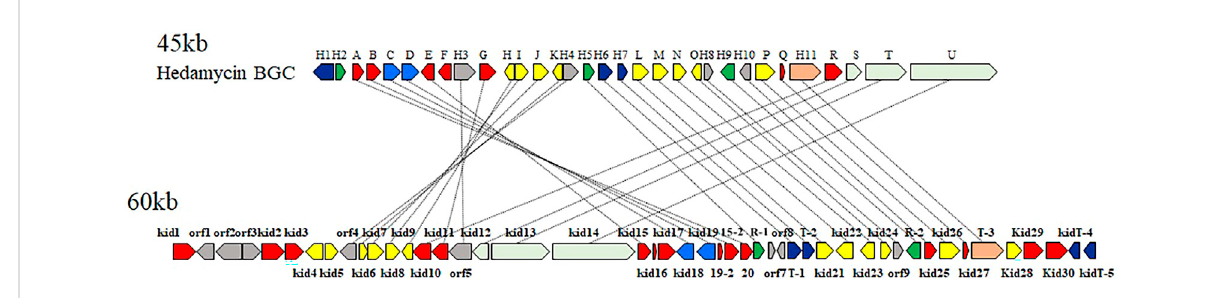
FIGURE 2 Comparison of the biosynthetic gene clusters encoding hedamycin (top) and kidamycin (bottom). Each arrow represents the direction of transcription of an open reading frame. Please see Supplementary Table S3 for complete cluster annotation.